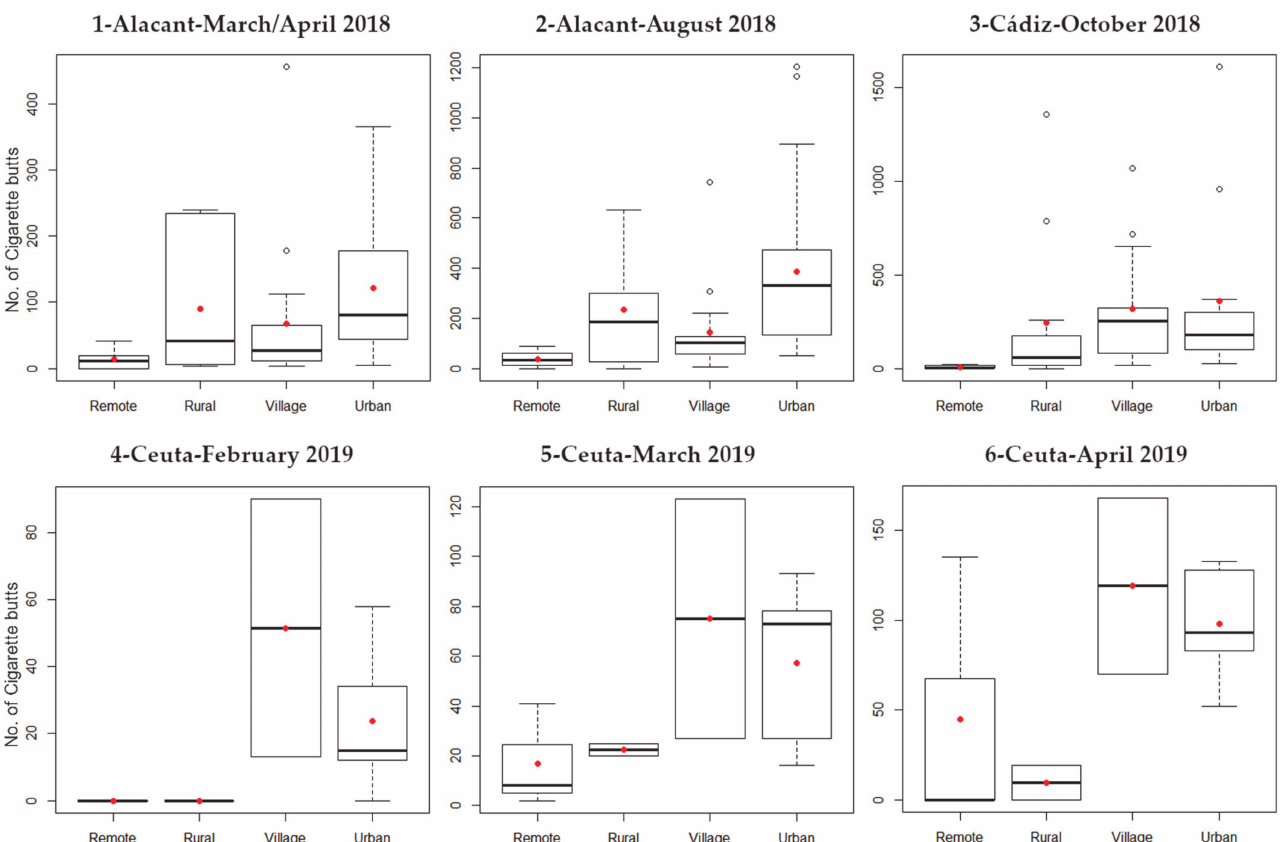
Figure A1. Box plots of total number of cigarette butts per beach typology in each one of the six